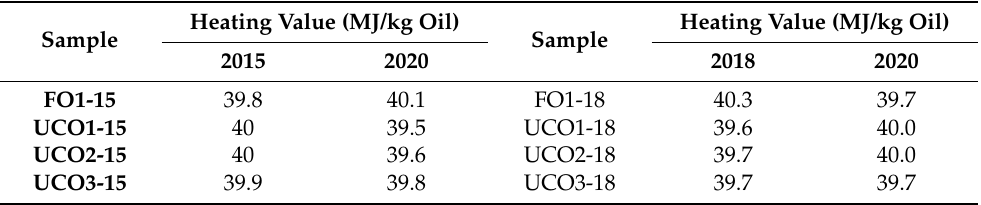
Table 4. The heating value of the fish oils (FOs) and UCOs samples determined before and after storage periods of two and five